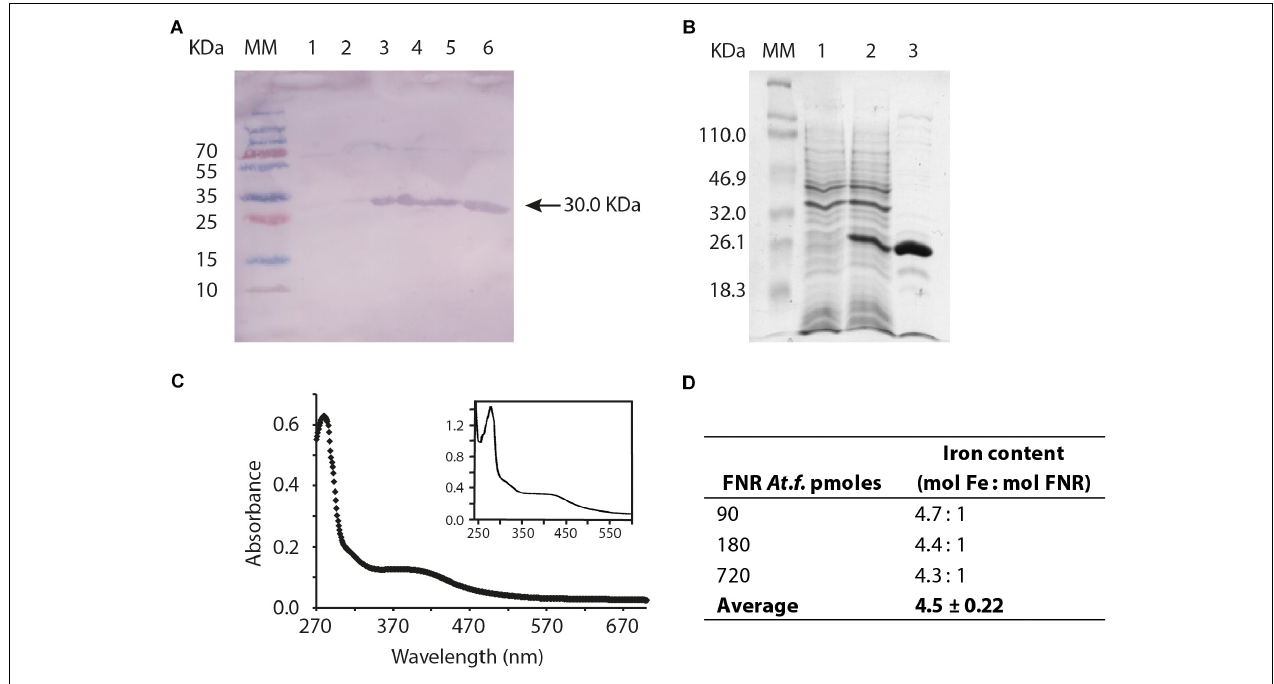
FIGURE 5 | Biochemical validation and properties of FNR AF . (A) Western blot, antibodies prepared against FNR EC were used to detect FNR AF , which was overproduced from plasmid pET100/D-TOPO fnr AF cloned into E. coli strain BL21. The gel shows the molecular mass marker (MM), crude cell free extract (approximately 10 µ g of total protein) prepared prior to induction of fnr AF expression with IPTG (lane 1), 10 µ g crude cell free extract 1 h after induction of fnr AF expression with IPTG (lane 2), and elution’s 1 to 4 of 10 µ g purified FNR AF protein after elution from the nickel column (lanes 3–6). (B) Overproduction and purification of FNR AF from the pET11A fnr AF plasmid as shown by SDS-PAGE analysis. Gel lane 1 shows crude cell free extract (approximately 10 µ g of total protein) prepared prior to induction of fnr AF expression with IPTG; lane 2, 10 µ g of crude cell free extract 1 h after induction of fnr AF expression with IPTG; and lane 3, 10 µ g FNR AF after the second cationic interchange chromatographic column. M, molecular mass marker ( M r are indicated). (C) Ultraviolet/visible absorption spectrum of a representative result of biological duplicates for purified FNR AF from anaerobically grown At. ferrooxidans with an inset of the ultraviolet/visible spectrum of anaerobically purified FNR EC taken from Lazazzera et al. (1993). (D) Calculation of the FNR AF iron content by spectrophotometric assay.